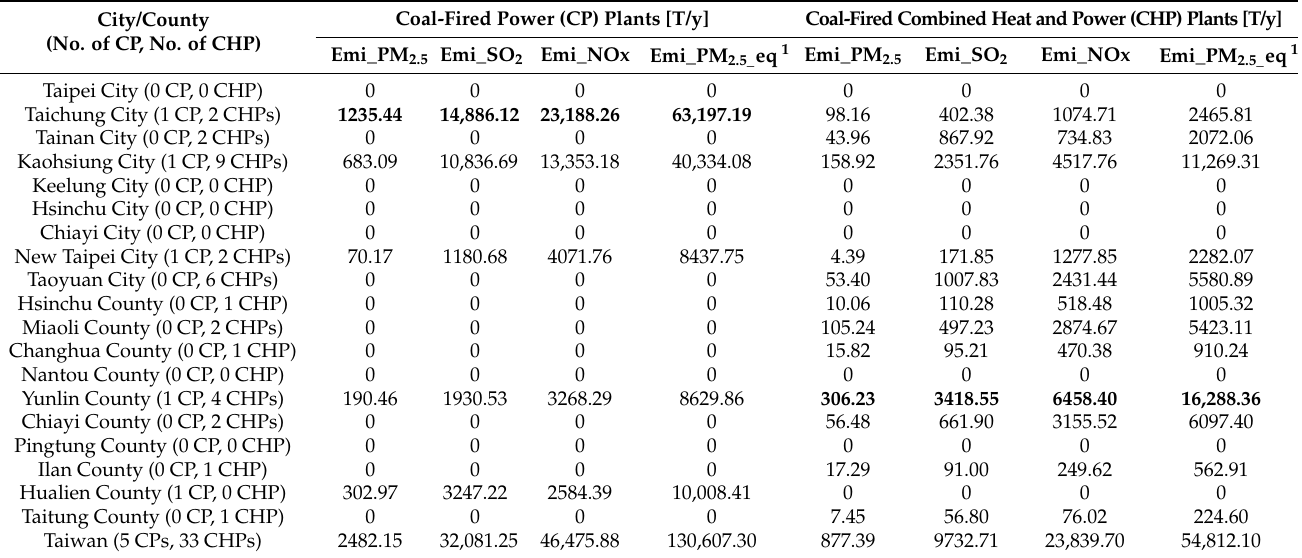
Table 1. City-/county-based emission inventories for CP and CHP plants in Taiwan. City/County (No. of CP, No. of CHP)